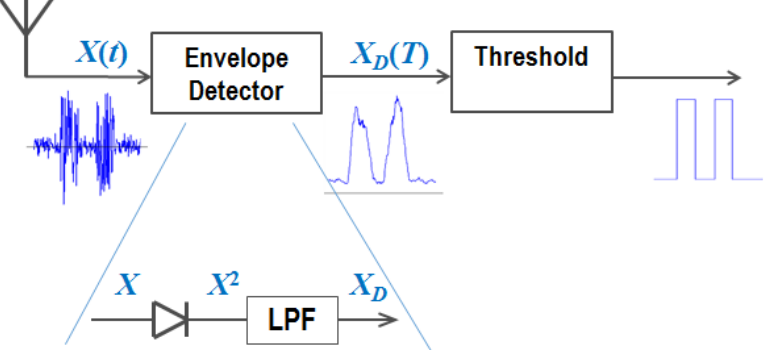
Figure 1. Energy detector of chaotic radio